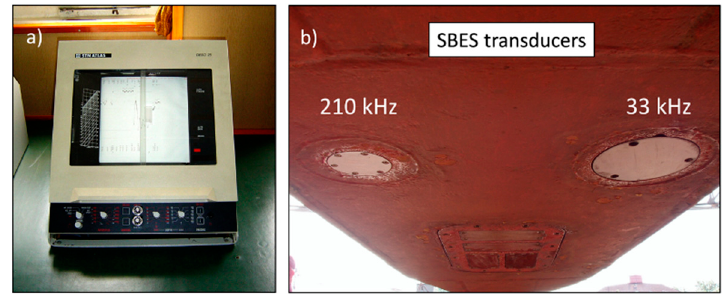
Figure 4. Components of single-beam echosounder. ( a ) graphic recorder and ( b ) keel-mounted transducers of low and high frequency.